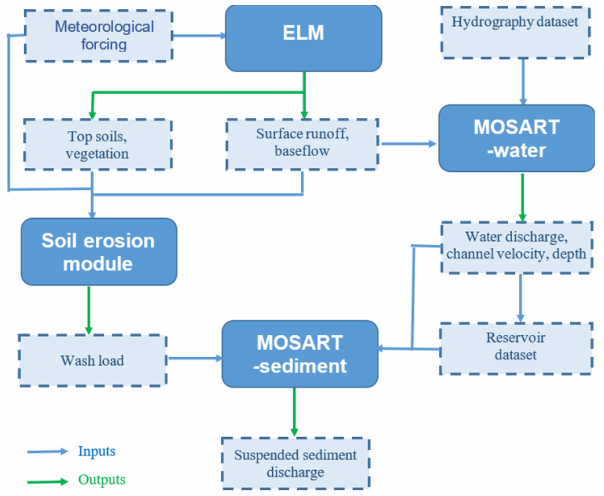
Figure 1. Modeling framework of